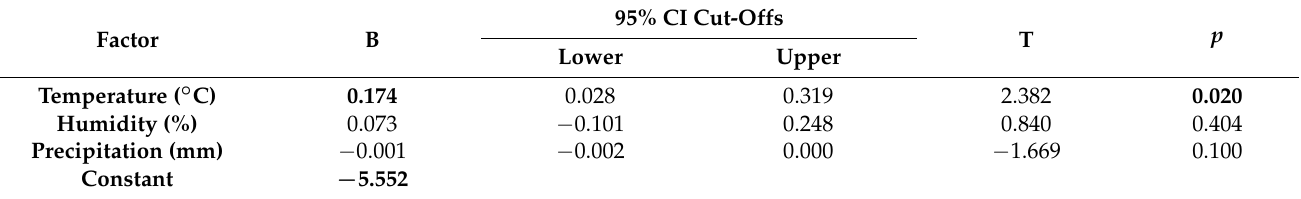
Table 6. Association between the number of cases of leishmaniosis from 1945 to 2014 in highland parts of Montenegro and average yearly values of meteorological factors (temperature, humidity, and